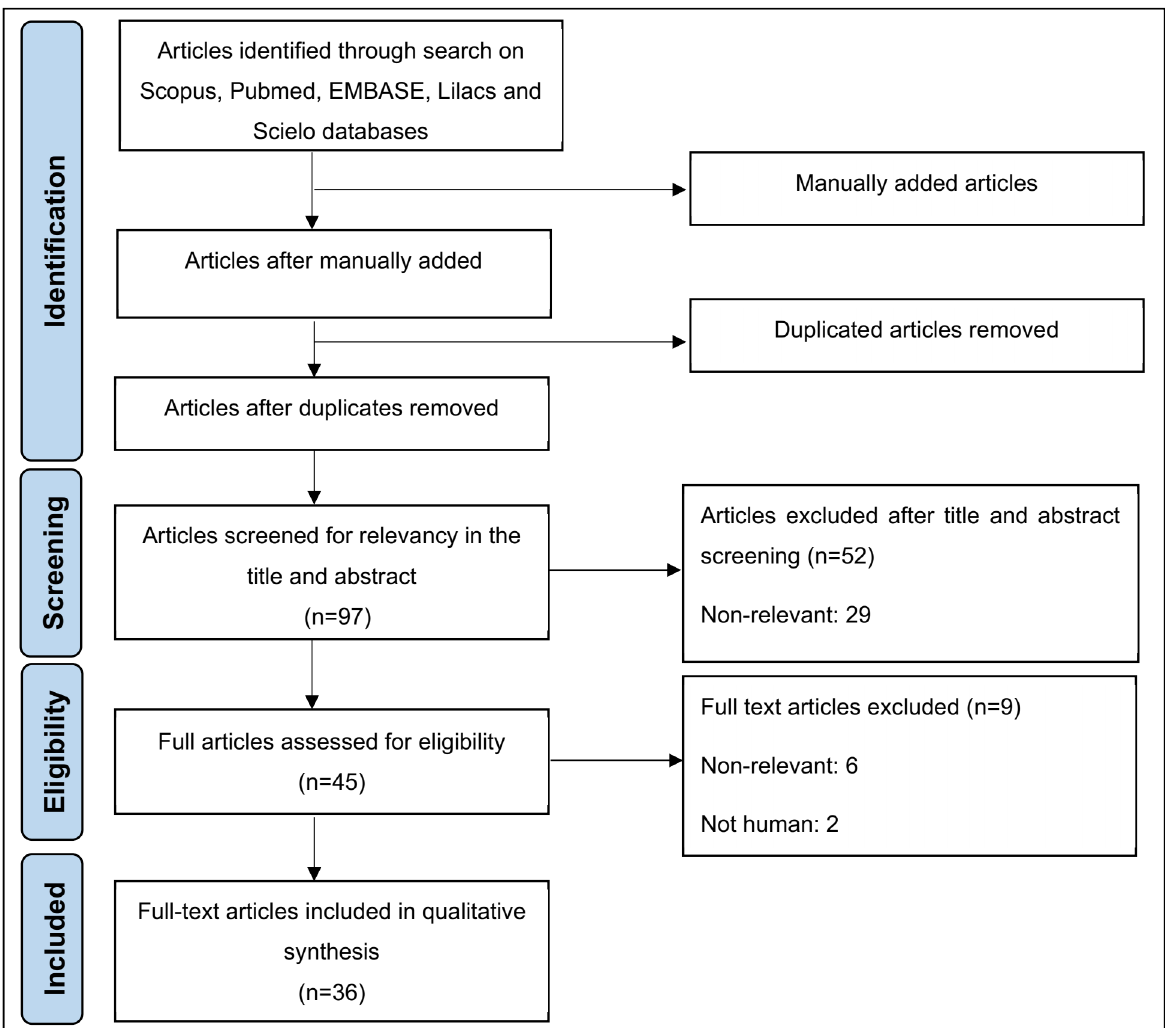
Figure 1. Flow diagram of the identification and selection of the studies, following the methodological steps of the PRISMA guidelines. steps of the PRISMA